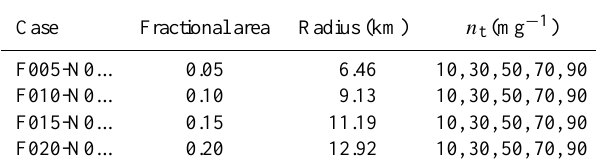
Table 1. List of cases for S2 simulations with a variety of single patches placed at the domain center. Each case branches off from N130 of S1 at 3h, and is run for 9h. Case name represents specified fractional area and n t of the patch. F015-N030 uses a patch with area fraction of 0.15 and n t = 30mg − 1